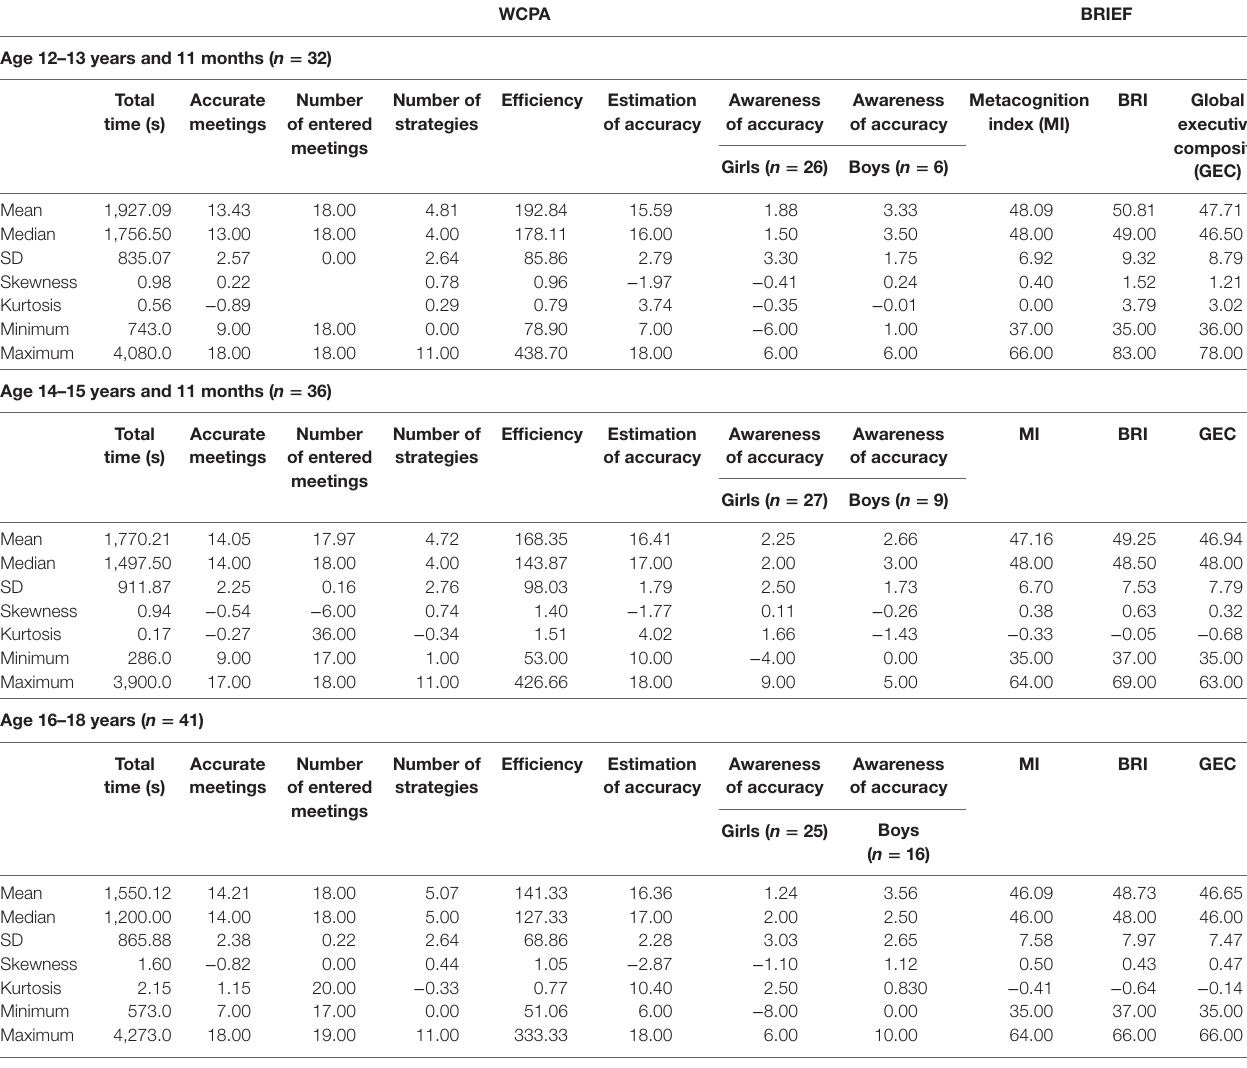
TaBle 1 | The weekly calendar planning activity (WCPA) and BRIEF subscales scores ( N = 109) across three age groups. WcPa